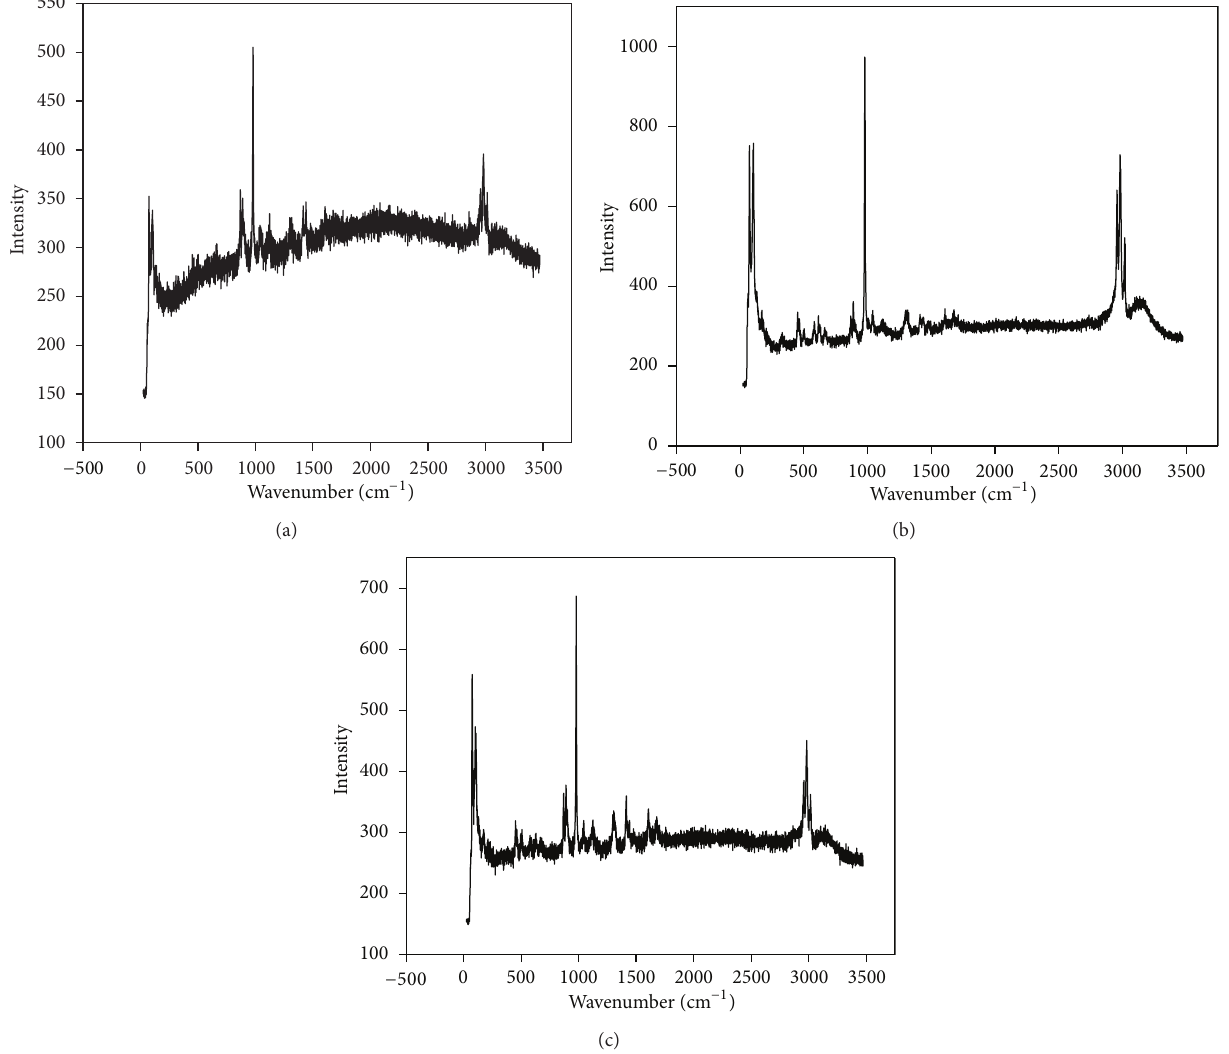
Figure 5: FT-Raman spectra of (a) TGSP (b) TGSP + ADP (c) TGSP + KDP crystals.